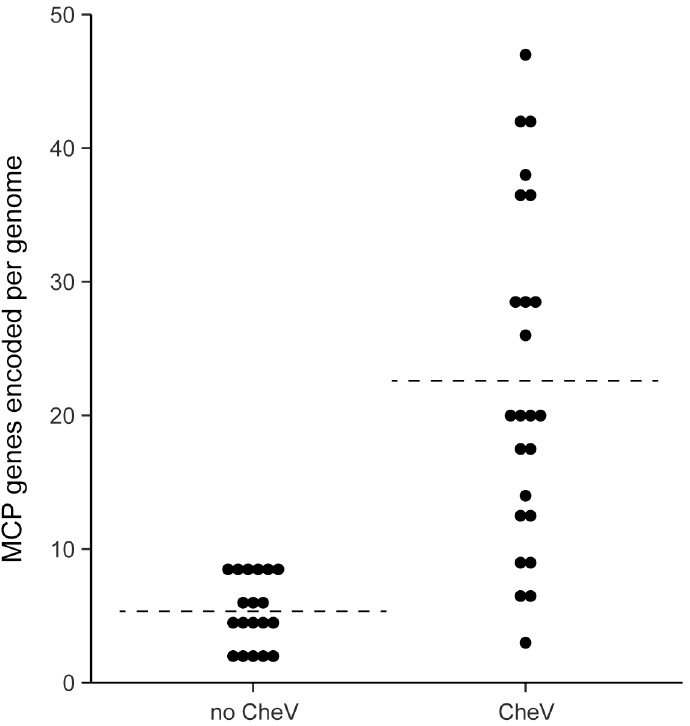
Fig 1. Number of MCP genes in 43 enterobacterial genomes with and without CheV. Each dot represents a genome. The dashed lines indicate the average number of MCPs for each